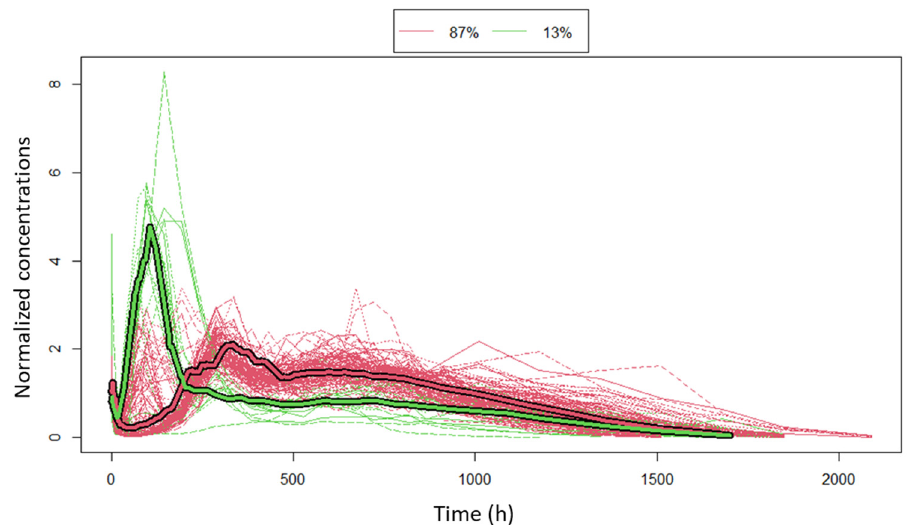
Figure 2. Two sub-populations were identified by the cluster analysis. The clusters are depicted with the different colour and the “mean typical profiles” are drawn with the bold line. Concentrations were normalized with the average concentration per subject to return the shape of exposure, therefore normalized concentrations on the y-axis are unitless.